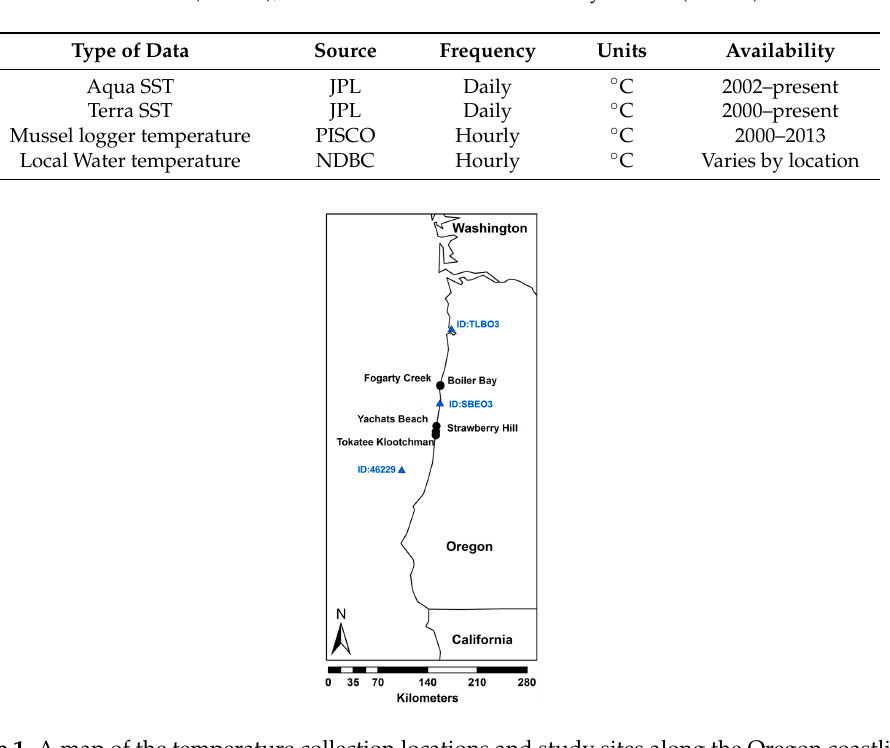
Table 1. Information about the type, source, frequency, availability, and web site address of the datasets